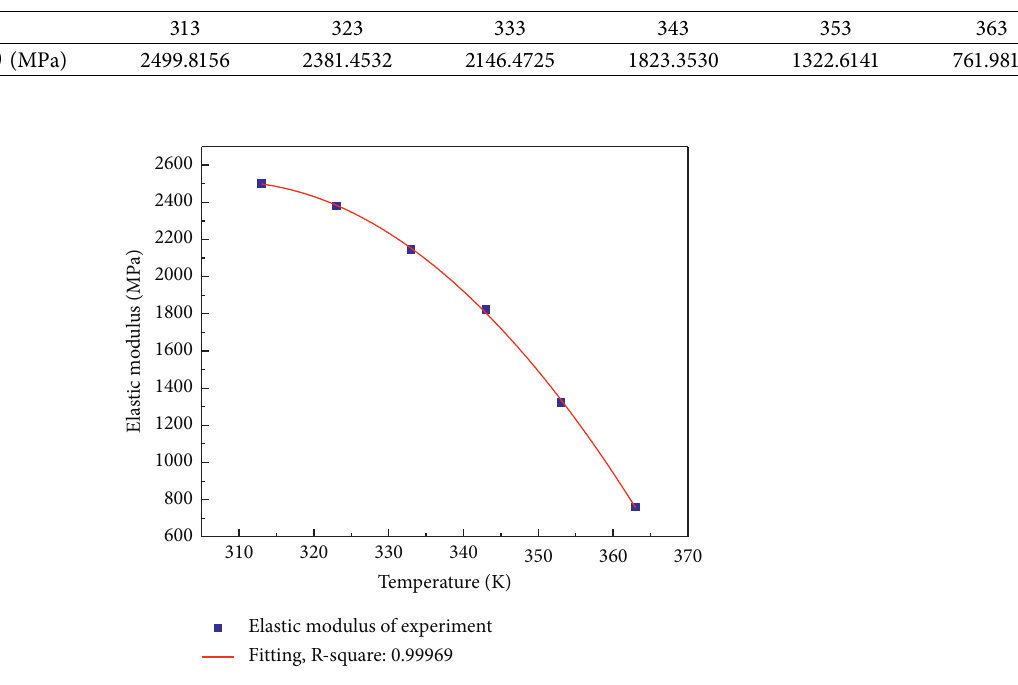
Table 2: Elastic modulus of ABS at different temperatures.